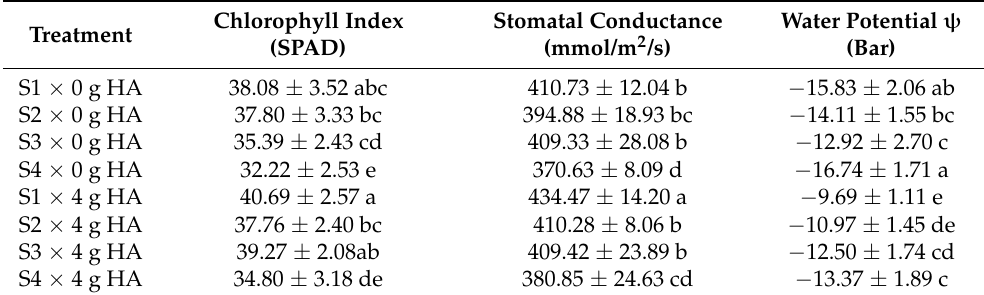
Table 6. Effect of substrate and humic acid on physiological variables of strawberry plants variety ‘Aroma’ during